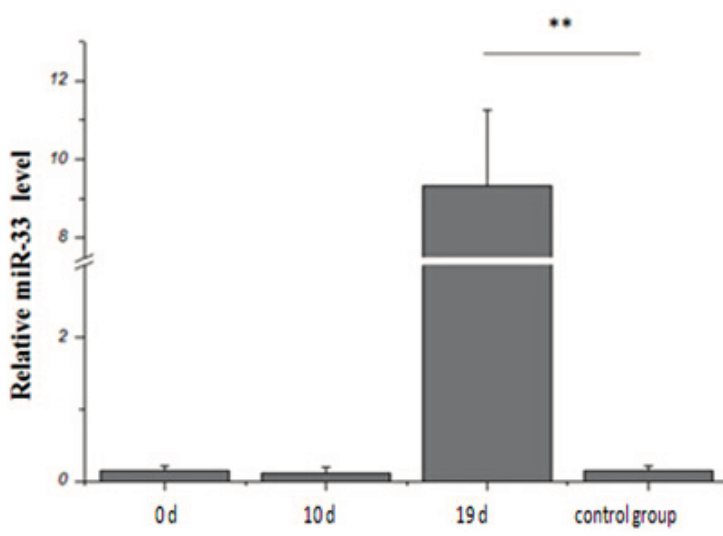
Figure 2. miR-33 expression during the overfeeding of Landes geese. ** represents p <